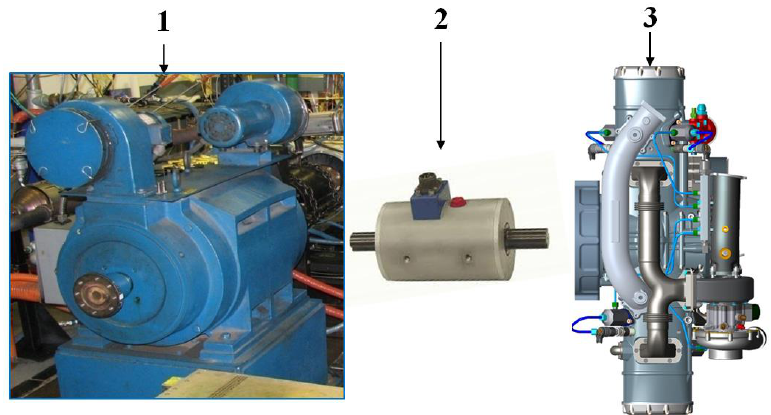
Figure 2. The scheme of the test bench and of the Eaton Lebow torque transducer: 1 — Eaton AC electric engine break (300 kW, 8000 rpm); 2 — Torque transducer Eaton Lebow (1000 Nm); 3 — EM100D engine.